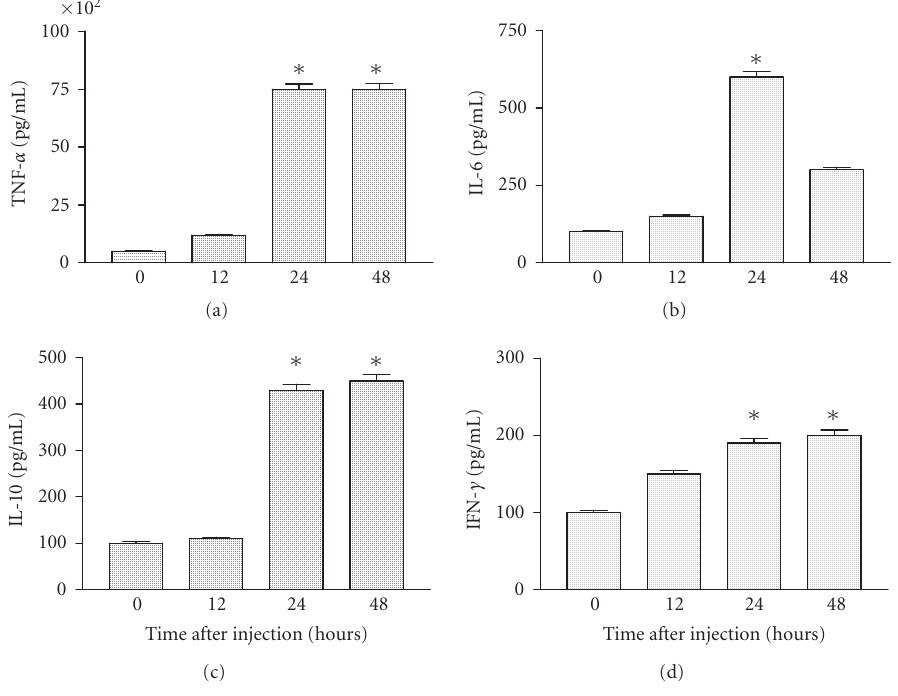
Figure 4: Mediators production on mice with moderate symptoms. Groups of mice were injected with di ff erent amounts of CSV. Mice were bled at di ff erent time intervals after injection and sera were separated for cytokine studies determined as described in “Materials and Methods.” Experiments were repeated twice and each point represents the value of pooled sera from 5 animals between the treatments were marked with asterisk ( P < . 001).